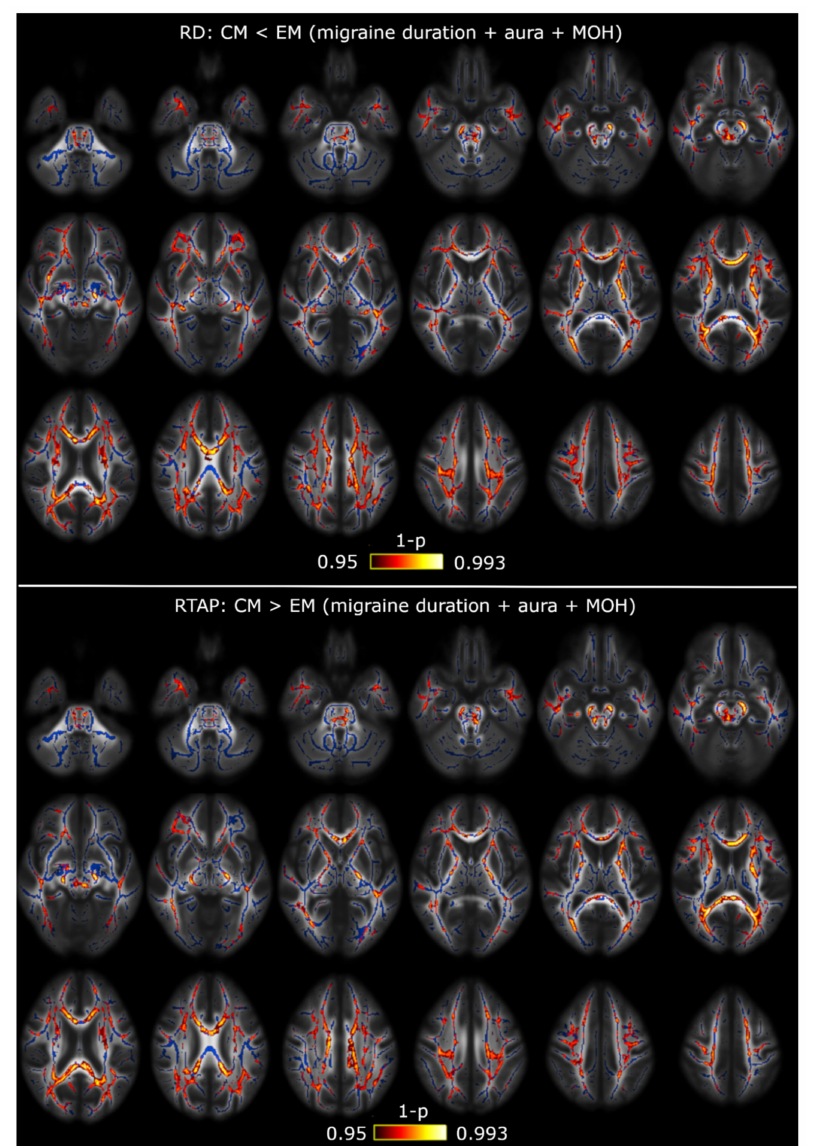
Figure A5. RD and RTAP alterations between CM and EM including duration of the migraine, presence of aura and medication overuse headache as covariates. TBSS showed decreased RD and increased RTAP values in CM with respect to EM. The white matter skeleton is shown in blue, and voxels with the lowest p -values in red-yellow. The color bar shows the 1-p-values (FWE-corrected). MOH = medication overuse